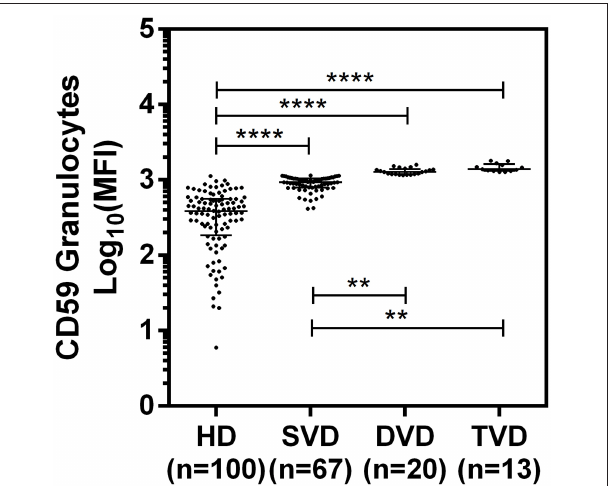
FIGURE 2 | Differential surface expression of CD59 on granulocytes of coronary artery disease patients with varied vessel blockage. Comparison of log-transformed median fluorescence intensity (Log 10 MFI) of CD59 shows significantly higher surface expression on granulocytes with increasing severity of disease. The Mann-Whitney U test was used for comparison of values between two groups and Kruskal-Wallis test was used for comparison between three groups. Two asterisks (**) indicate a p -value of < 0.01, and four asterisks (****) indicate a p -value of < 0.001.